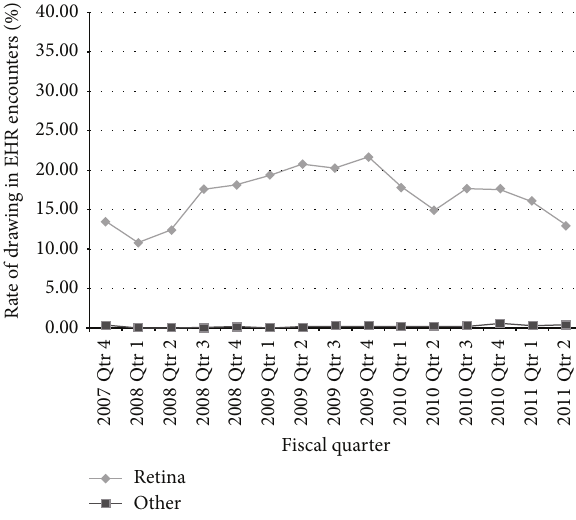
Figure 4: The rate of drawings created in all patient EHR visit encounters over a 4-year period for retina specialists versus other ophthalmologists (comprehensive, cornea, and glaucoma special- ists, pediatric ophthalmology, oculoplastics, neuroophthalmology, and